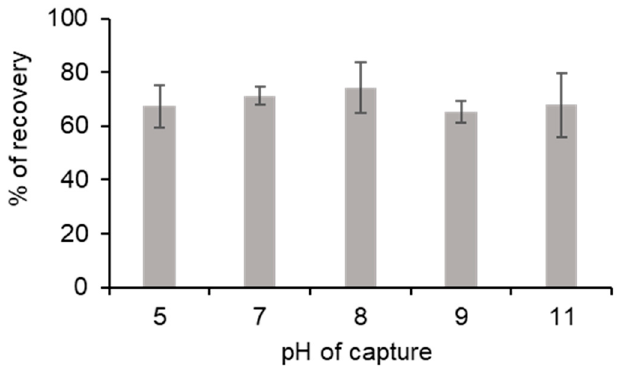
Figure 4. Influence of the pH on DNA capture. Five pH capture samples were tested. The percentage recovery corresponded to the percentage of DNA recovered after the process ended. Error bars represent the standard deviation for n = 3.